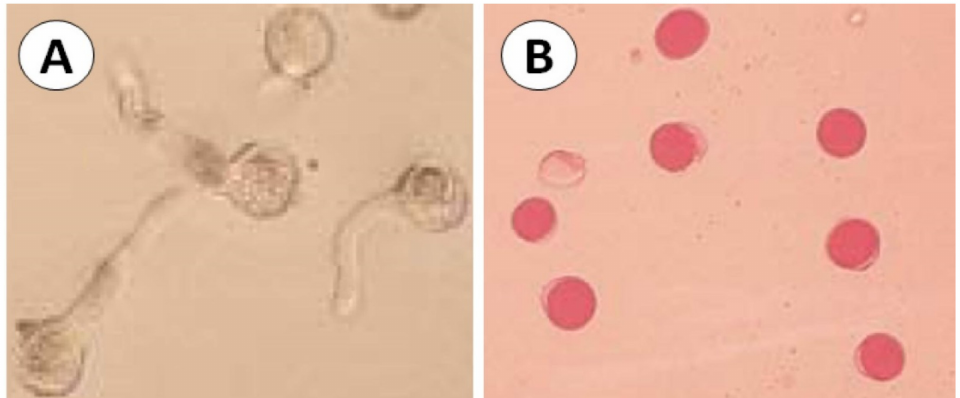
Figure 4. Two methods for determining DPP viability. ( A ) The germination ability on germinating medium. The growth of the pollen tube is observed as a success in viability in three germinated grains, while a non-germinated pollen grain appears in the upper part, which indicates non-viability. ( B ) The differential stainability of the pollen grains with acetocarmine. The red tinted dots show viability, while the unstained dot indicates non-viability. Images adapted from